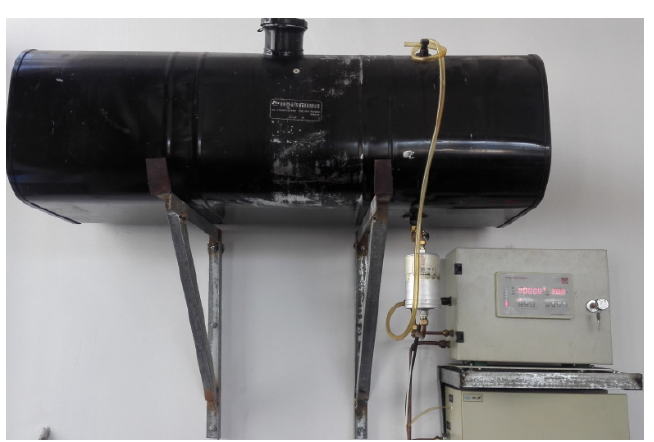
Figure 8. Fuel tank and recorder.